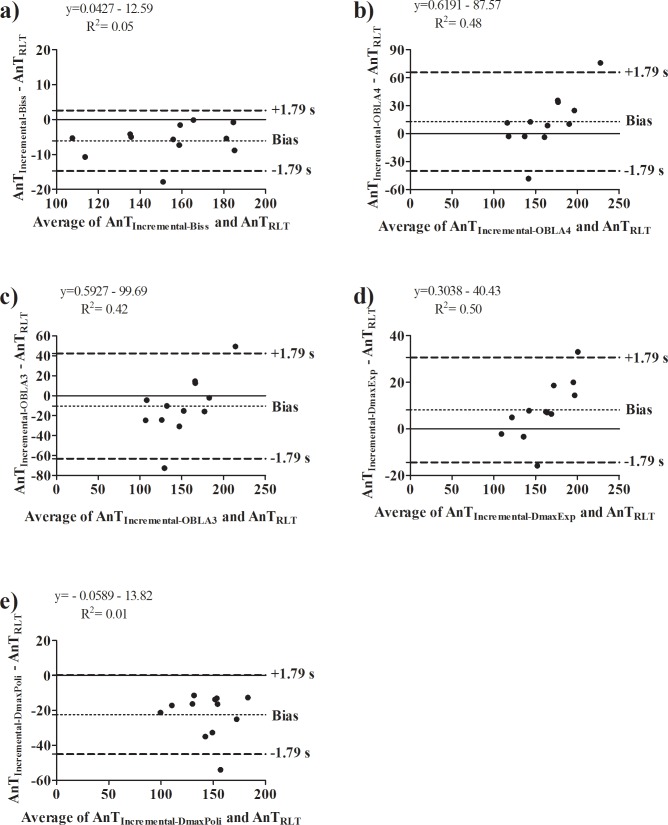
Bland-Altman analysis performed for anaerobic threshold intensity determined on the reverse lactate threshold test and incremental protocol on experienced individuals.a) Agreement between anaerobic threshold intensity determined on incremental protocol by the bissegmentation method (AnTInc-Biss) and reverse lactate threshold test (AnTRLT); b) Agreement between anaerobic threshold intensity determined on incremental protocol by fixed blood lactate concentration at 4 mmol.L-1 (AnTOBLA4) and AnTRLT; c) Agreement between anaerobic threshold intensity determined on incremental protocol by fixed blood lactate concentration at 3 mmol.L-1 (AnTOBLA3) and AnTRLT; d) Agreement between anaerobic threshold intensity determined on incremental protocol by maximal deviation method using the exponential adjustment (AnTDmaxExp) and AnTRLT; e) Agreement between anaerobic threshold intensity determined on incremental protocol by maximal deviation method using the second order polynomial adjustment (AnTDmaxPoli) and AnTRLT.